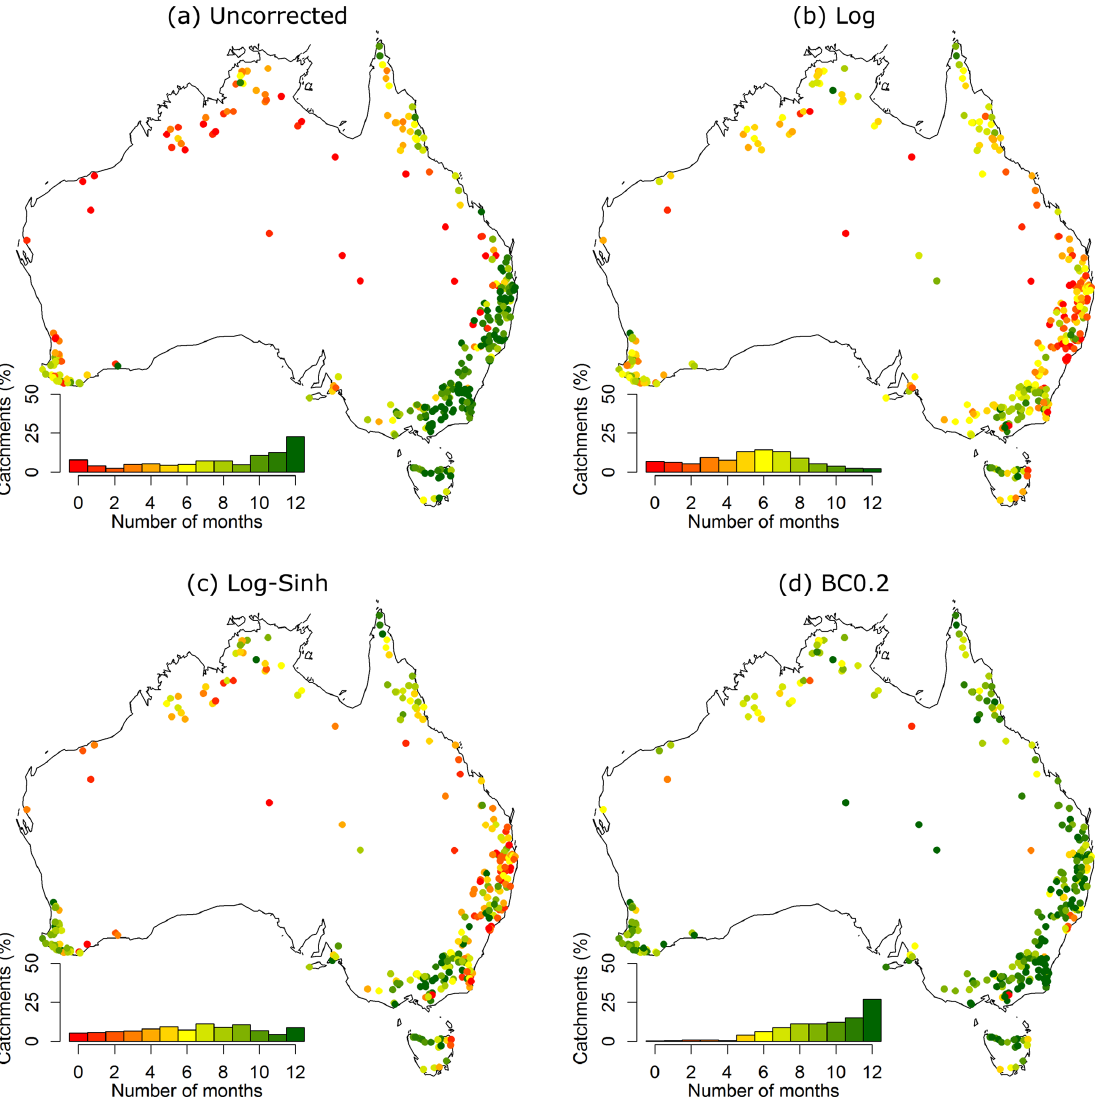
Figure 11. Summary skill of seasonal forecasts obtained using the Log, Log-Sinh, and BC0.2 schemes across 300 Australian catchments. See Fig. 10’s caption for